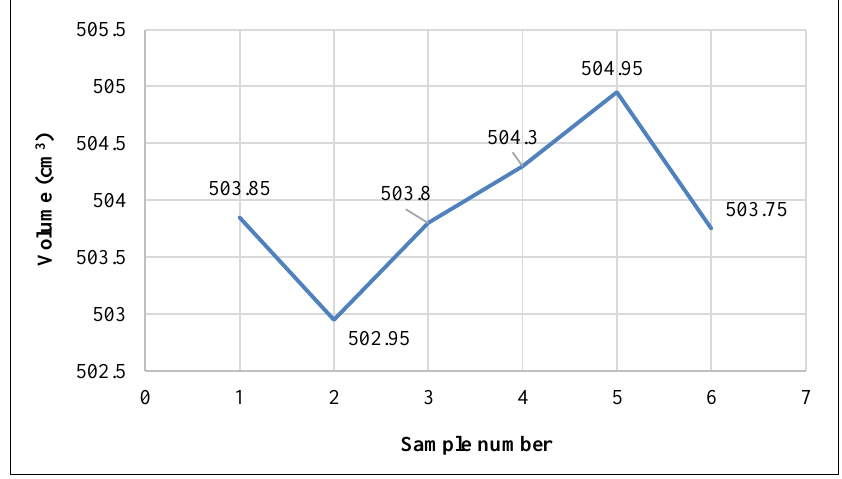
Figure 24. Volume for six